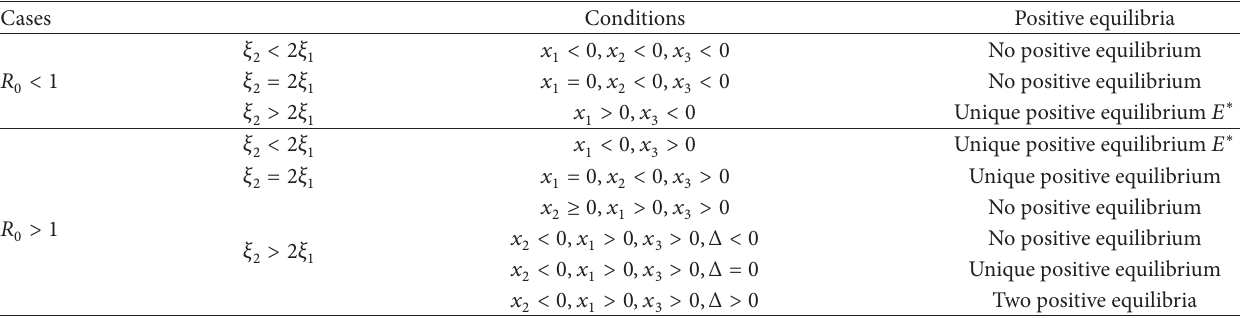
Table 2: Equilibria and stability of system